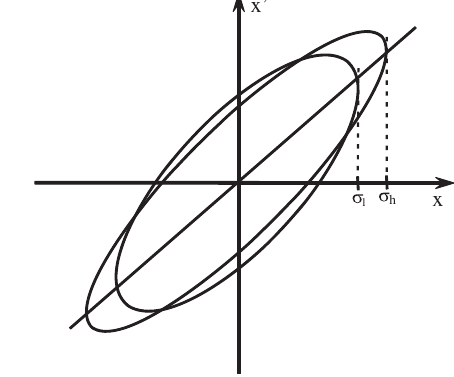
FIG. 5. Emittance growth due to a mismatch of the beam sizes.